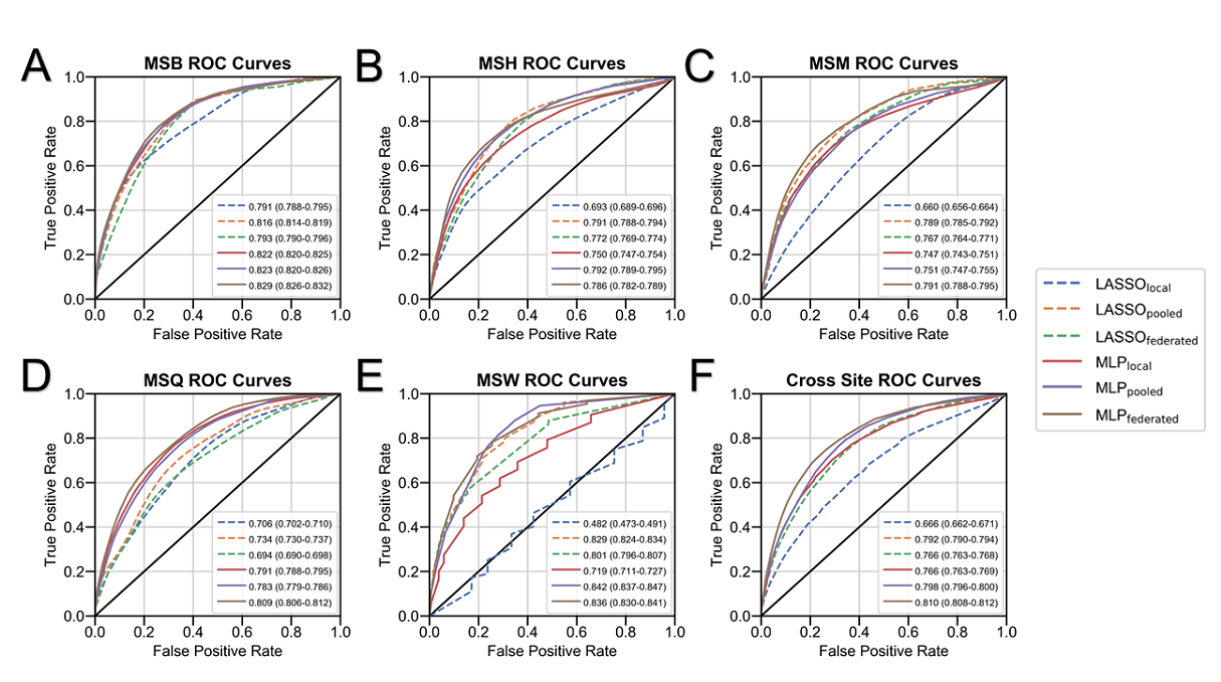
Figure 3. Model performance by site. The performance of all models (ie, local LASSO, pooled LASSO, federated LASSO, local MLP, pooled MLP, and federated [no noise] MLP models) based on areas under the ROC curve at (A) MSB (n=611), (B) MSW (n=485), (C) MSM (n=749), (D) MSH (n=1644), and (E) MSQ (n=540). Average areas under the ROC curve with 95% confidence intervals (ie, after the 70%-30% training-testing data split over 490 experiments) are shown. (F) The average performance of each model across all 5 sites. LASSO: least absolute shrinkage and selection operator; MLP: multilayer perceptron; MSB: Mount Sinai Brooklyn; MSH: Mount Sinai Hospital; MSM: Mount Sinai Morningside; MSQ: Mount Sinai